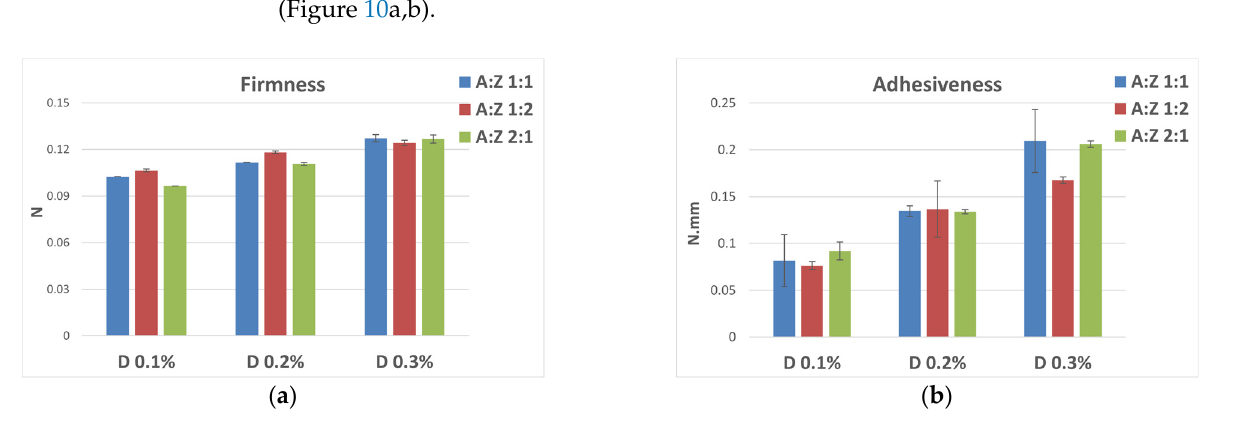
Figure 10. Textural parameters and standard deviations of firmness ( a ) and adhesiveness ( b ) measured by an immersion/de-immersion test for the emulsions prepared with A-Z associations (1:1) and the polysaccharides D, S, and X at 0.3% w/w.